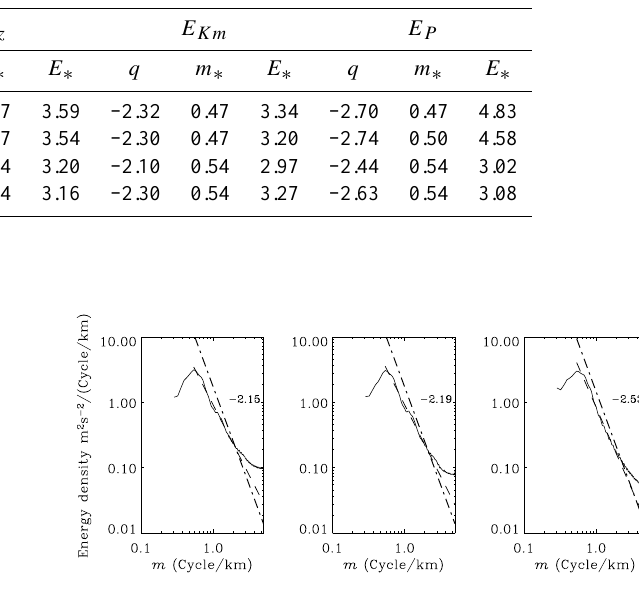
Fig. 3. Similar to Fig. 2, but for the averaged vertical wave number spectra in the lower stratosphere over Wuhan